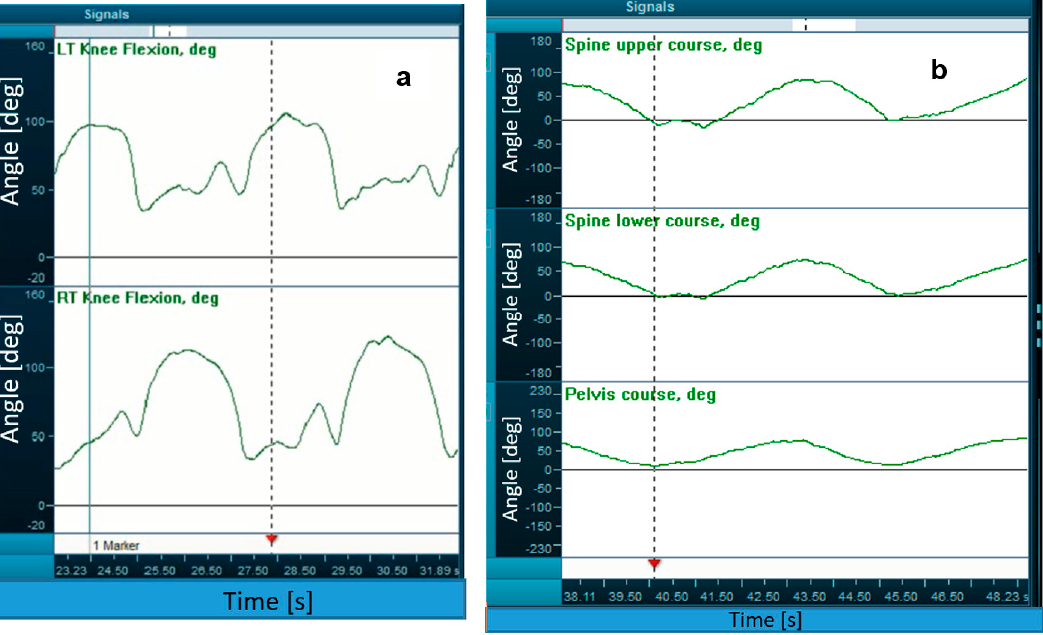
Figure 3. Technique characteristics: ( a ) range of motion in the knee joints; ( b ) time sequences in the rotational turn.